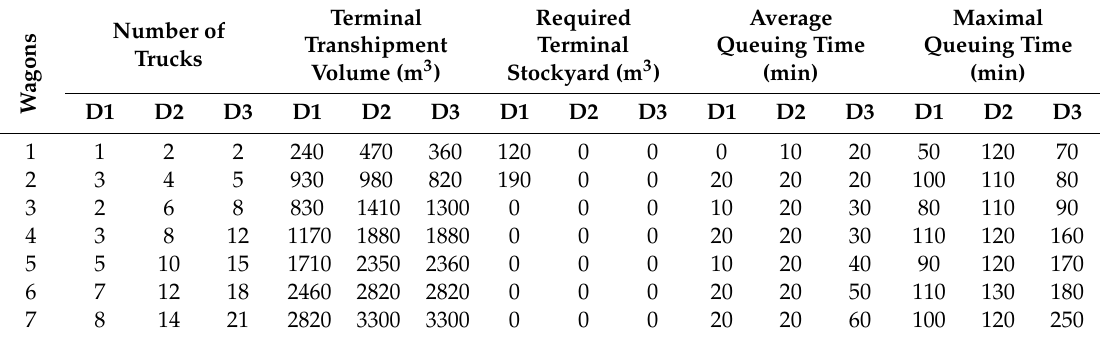
Table 9. Best performing simulation results for strategy NO STOCKYARD (no or low required terminal stockyard) for two train pick-ups.